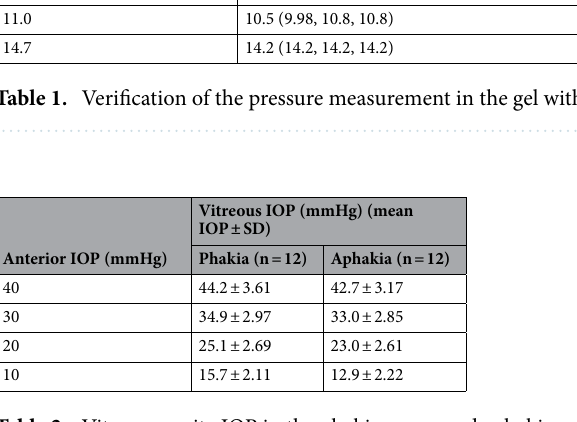
Table 2. Vitreous cavity IOP in the phakia group and aphakia group when anterior chamber IOP reached each target